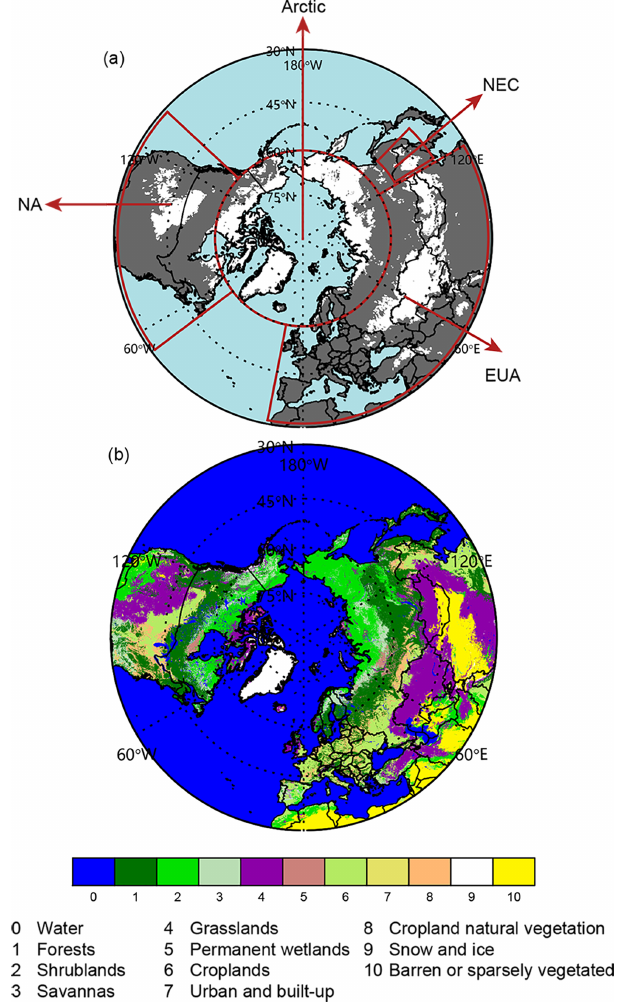
Figure 3. Spatial distributions of (a) the identified snow-covered area (ISCA) and (b) the different land cover types based on MODIS data for the Northern Hemisphere. ISCAs (white) can be sepa- rated into northeastern China (NEC), Eurasia (EUA), North Amer- ica (NA), and the